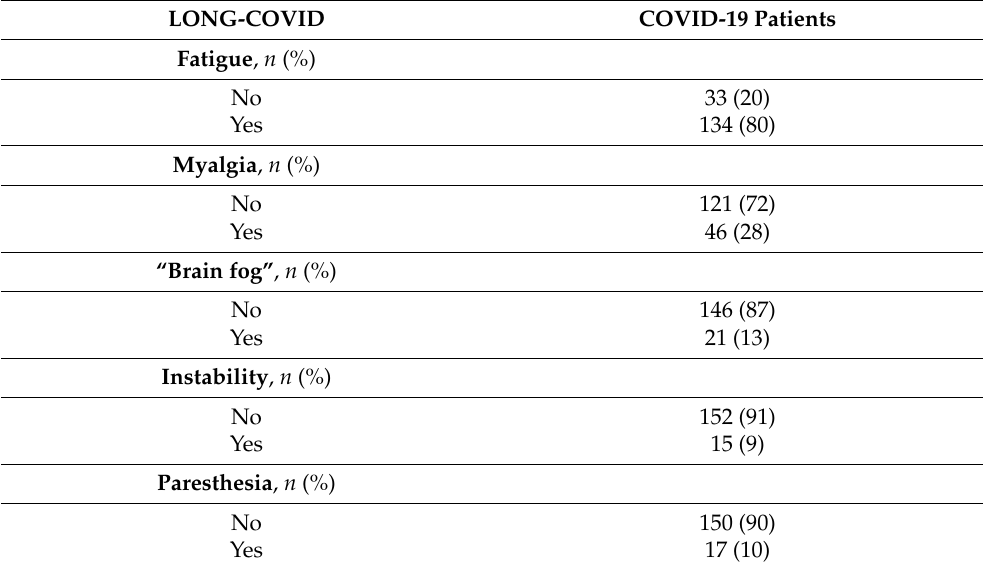
Table 3. Neurological manifestations in